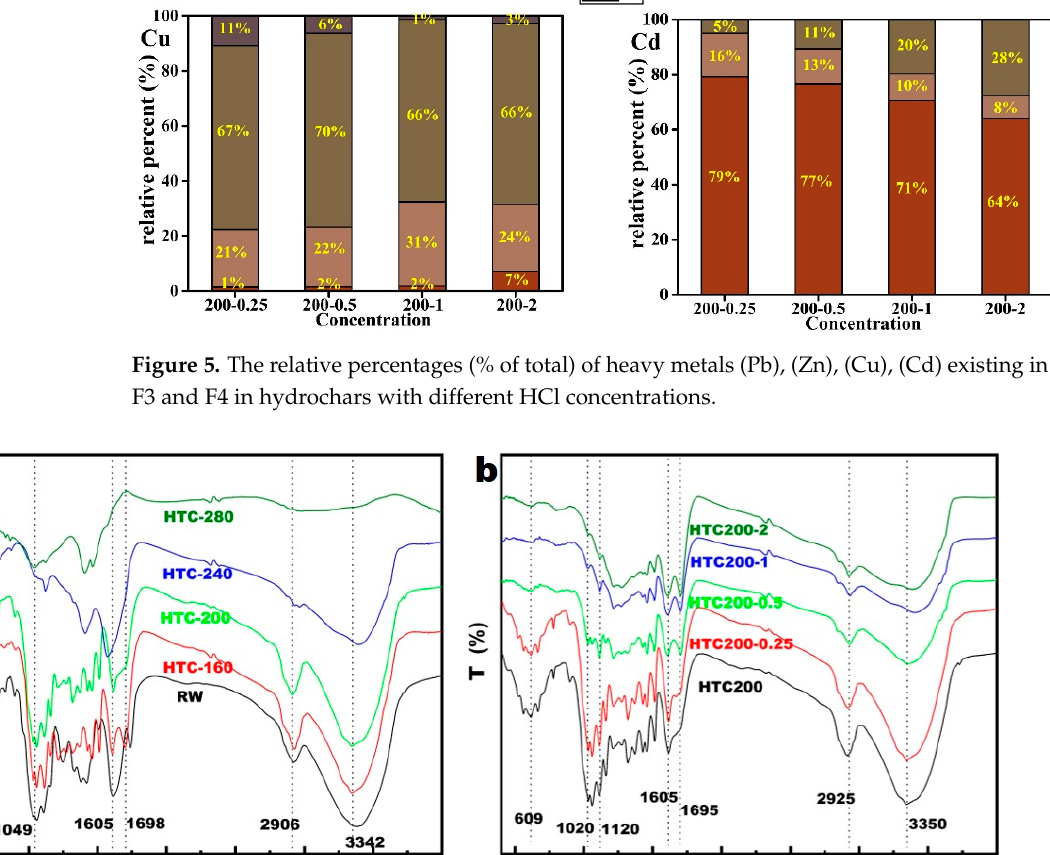
Figure 6. The FTIR of hydrochar prepared at different temperatures ( a ) and with different HCl concentrations ( b ).